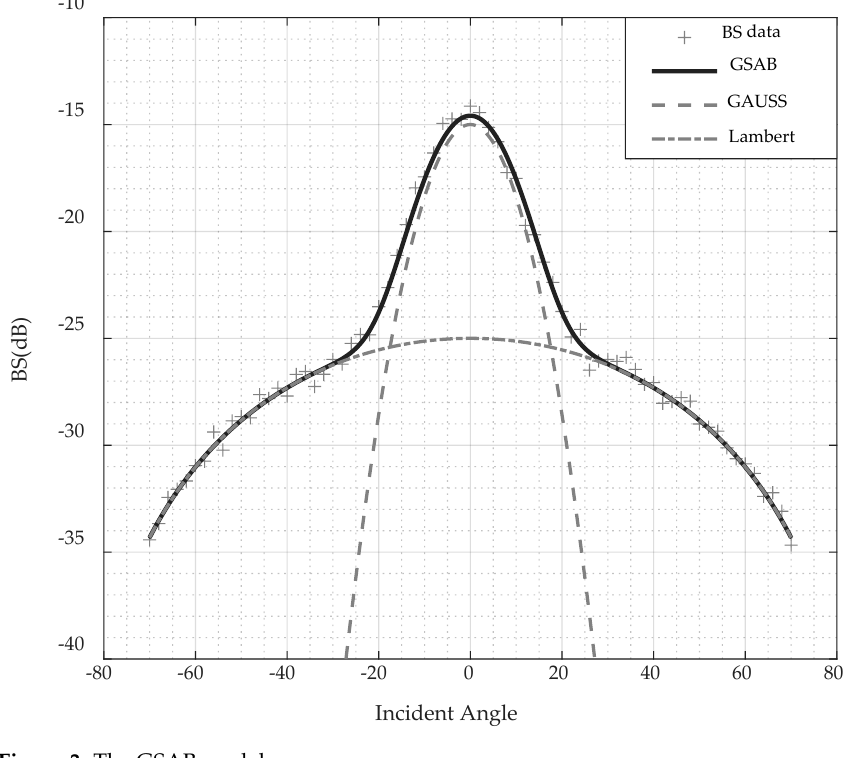
Figure 3. The GSAB model. The angular response curves obtained by the least squares method are biased due to the effects of beam pattern residuals and noise. Therefore, we use the Huber regression to weaken the side effects of outliers on model